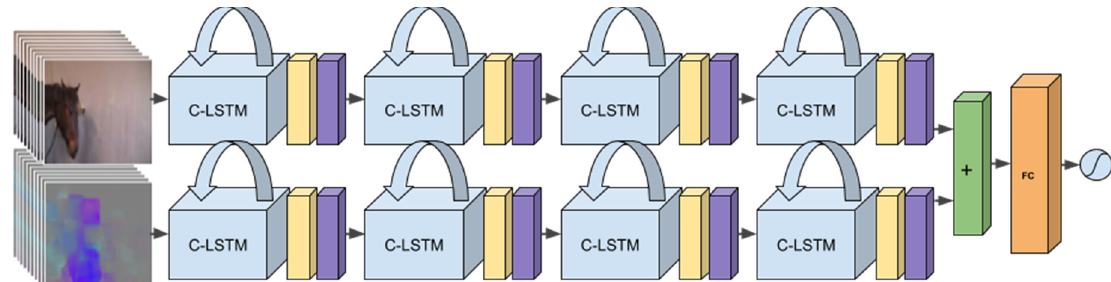
Figure 3. Deep recurrent two-stream network for end-to-end detection of pain from a sequence of Red-Green-Blue (RGB) images and optical flow images. Each optical flow image is computed from two subsequent RGB images using standard image processing techniques. From [117].